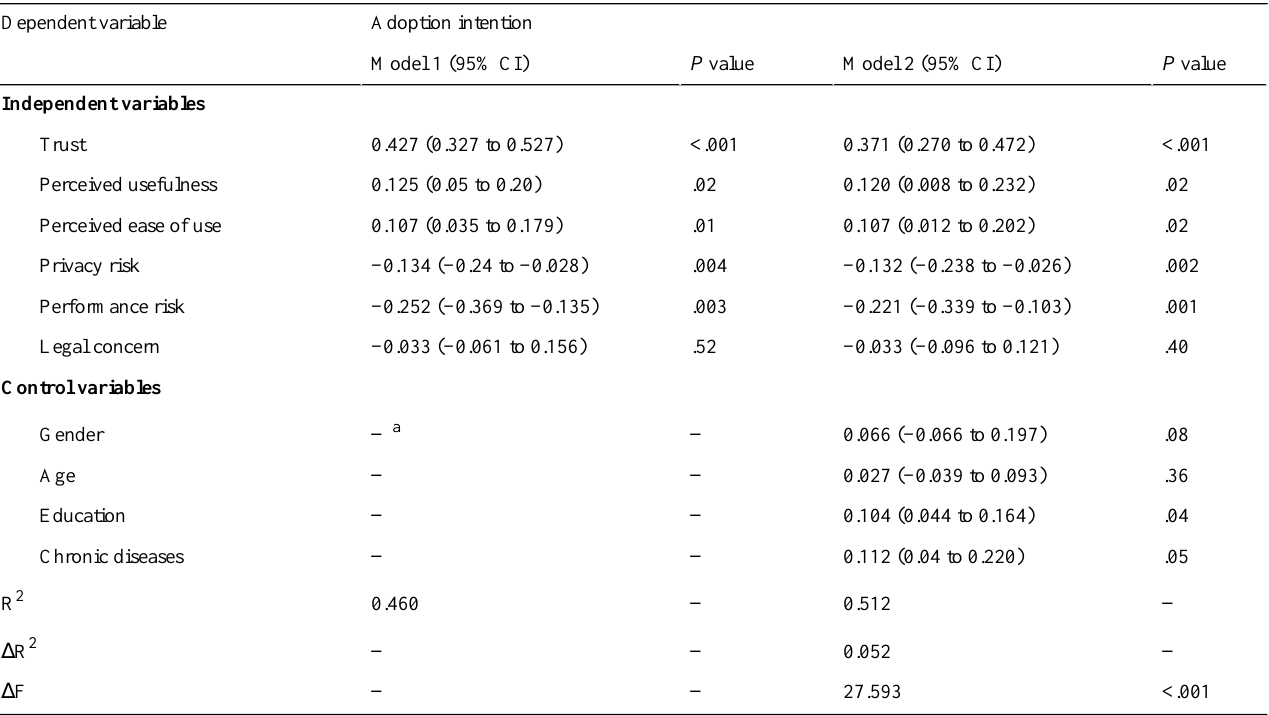
Table 6. Results of multiple linear regression analysis for dependent variable Adoption Intention. R 2 : coefficient of determination, Δ R 2 : change in the coefficient of determination, Δ F: change in the